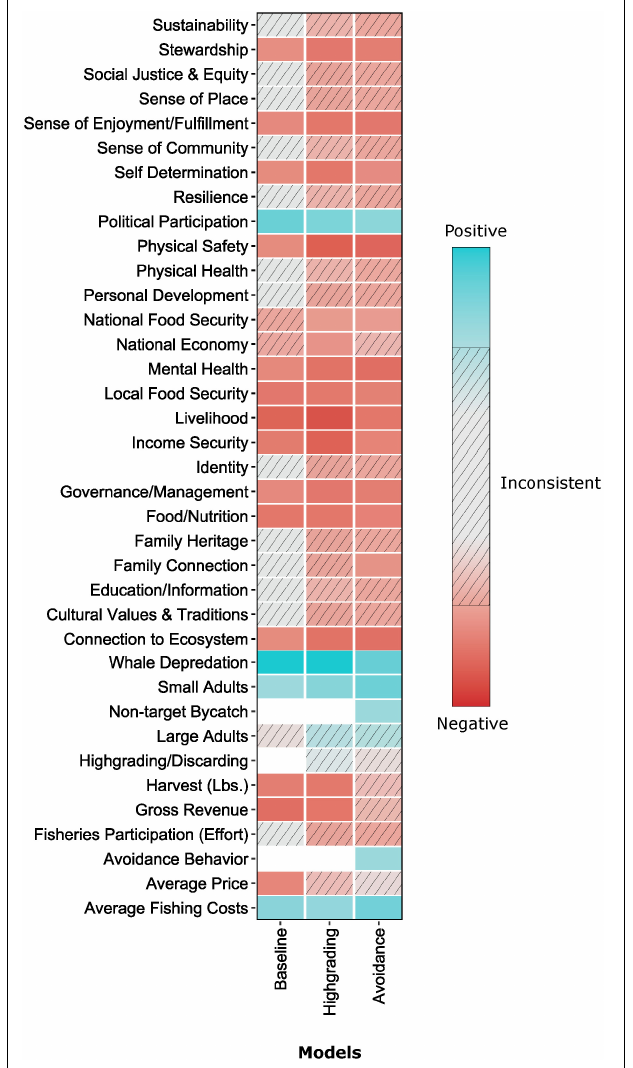
FIGURE 8 | Results from 10,000 simulations to a positive perturbation in small adults and whale depredation for the baseline highgrading, and avoidance behaviors models. The squares indicate the probability of a positive (blue) or negative (red) response of the variables ( y -axis) within each model ( x -axis). Shading increase corresponds with an increase in sign consistency and the textured squares represent inconsistent results that are less than the 70% cutoff. Figure created with R package “ggplot2” (Wickham, 2016; R Core Team, 2019).